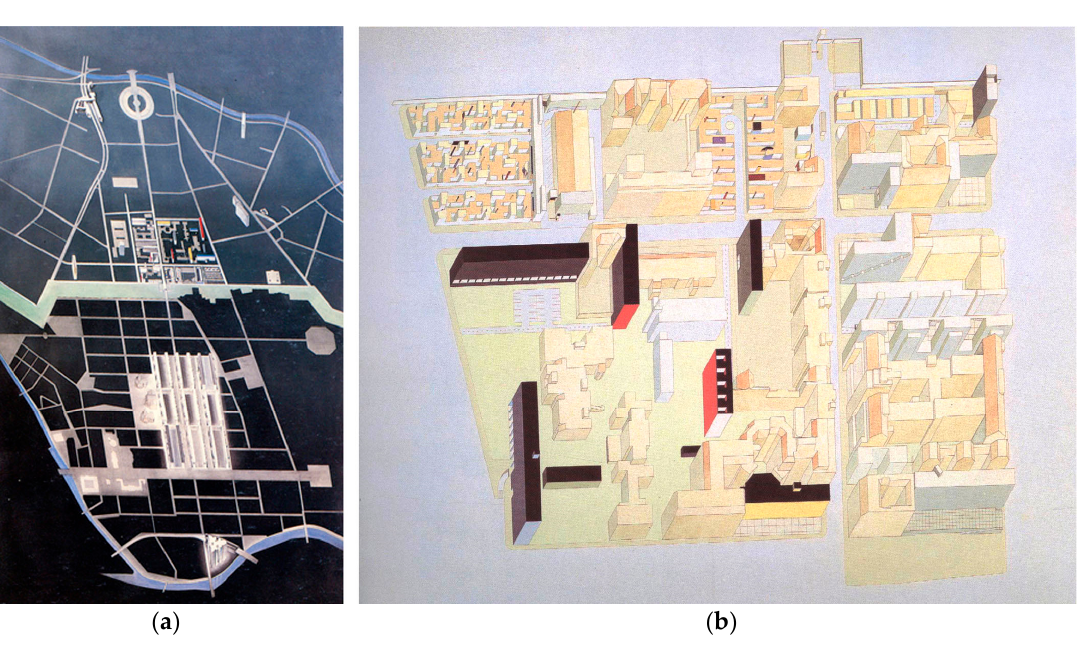
Figure 5. Rem Koolhaas, OMA, plates for IBA 84. ( a ) Bird’s eye view; ( b ) Axonometric view of Blocks 4, 5, 10, 11,